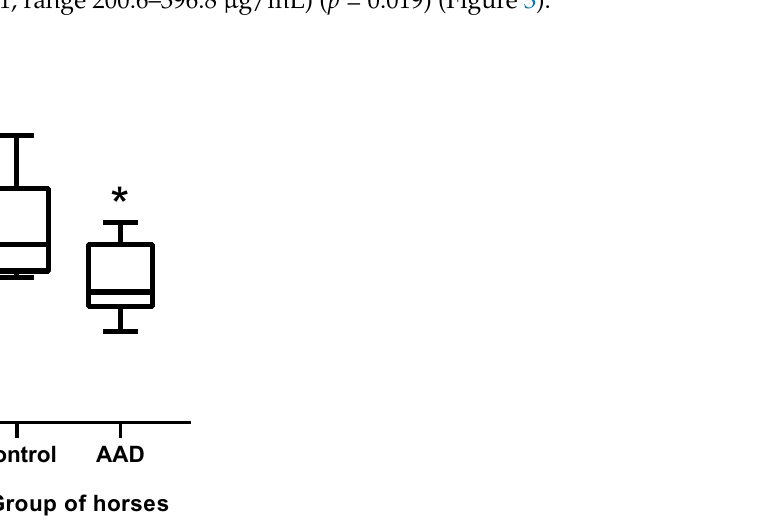
Figure 3. Lactoferrin concentrations in horses with AAD ( n = 8) compared with healthy horses ( n = 8). The plot shows the median (line within box), 25th and 75th percentiles (box), and 10th and 90th percentiles (whiskers). Asterisk indicates a significant difference between groups: * p < 0.05. AAD: acute abdominal disease.